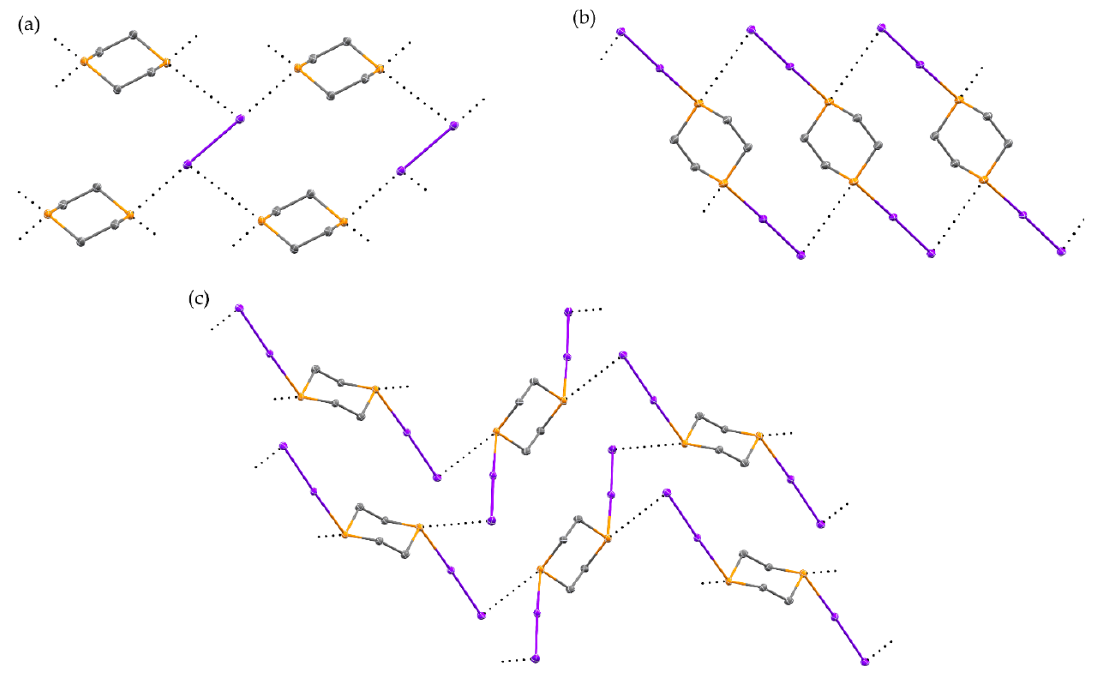
Figure 4. The solid-state structure of 4 ( a ), 5 ( b ), and 6 ( c ). Intermolecular interactions are shown as black dotted lines. Hydrogen atoms have been omitted for clarity. Atomic displacement ellipsoids are shown at the 50% probability level.